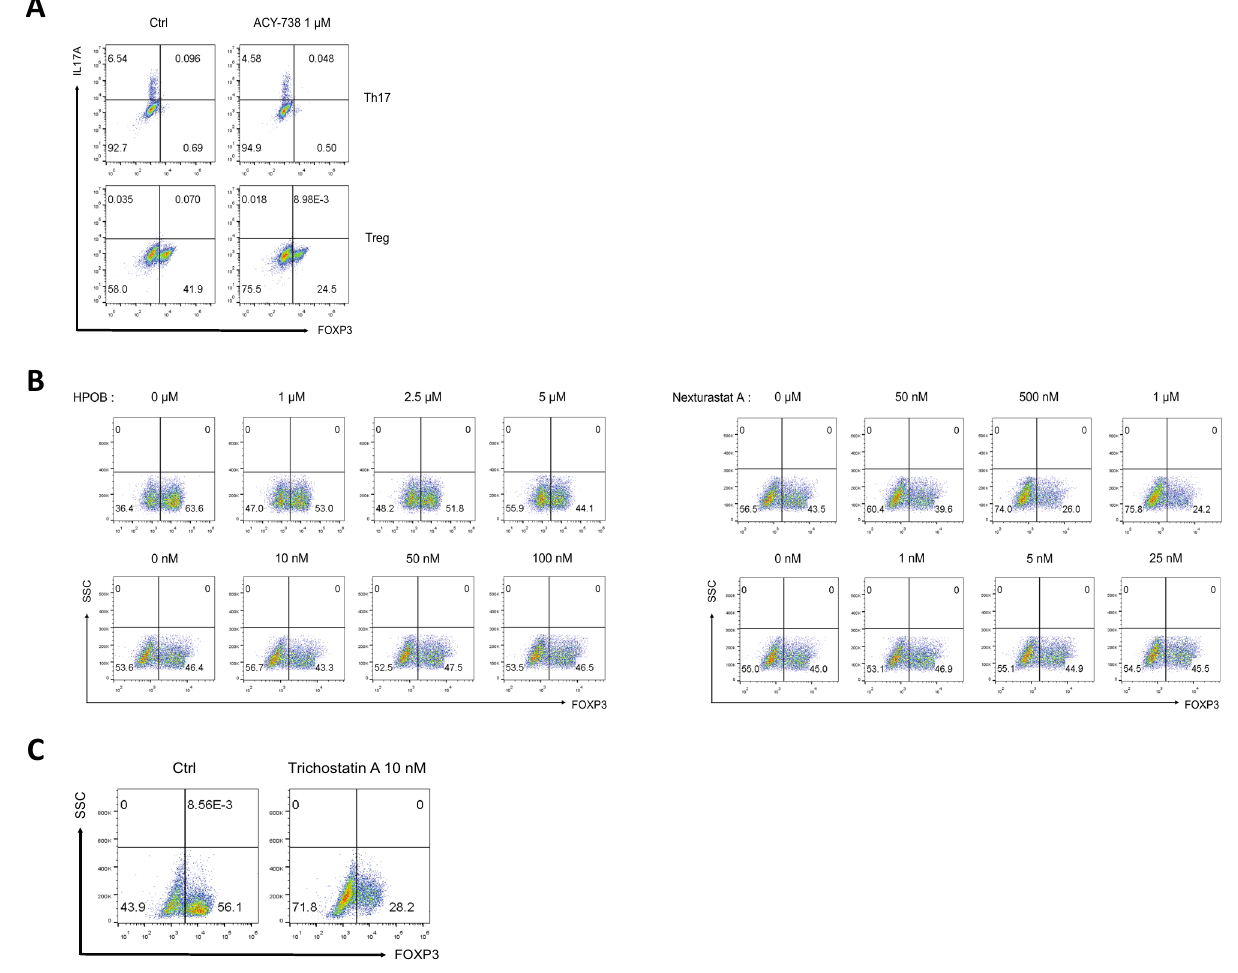
Figure 3. Various pharmacological inhibitors of HDAC6, or a pan-HDAC inhibitor, prevent iTreg differentiation. ( A ) Naïve CD4 + T cells were differentiated for 3 days into Th17 or Treg cells in the presence of vehicle control or ACY-738 (1 µM). The percentage of IL-17A + and FOXP3 + cells was analyzed by flow cytometry. ( B ) Naïve CD4 + T cells were differentiated for 3 days into Treg cells in the presence of various concentrations of HPOB (top) or Nexturastat A (bottom), and the percentage of FOXP3 + cells was analyzed by flow cytometry. ( C ) Naïve CD4 + T cells were differentiated for 3 days into Treg cells in the presence of vehicle control or Trichostatin A (10 nM). The percentage of FOXP3 + cells was analyzed by flow